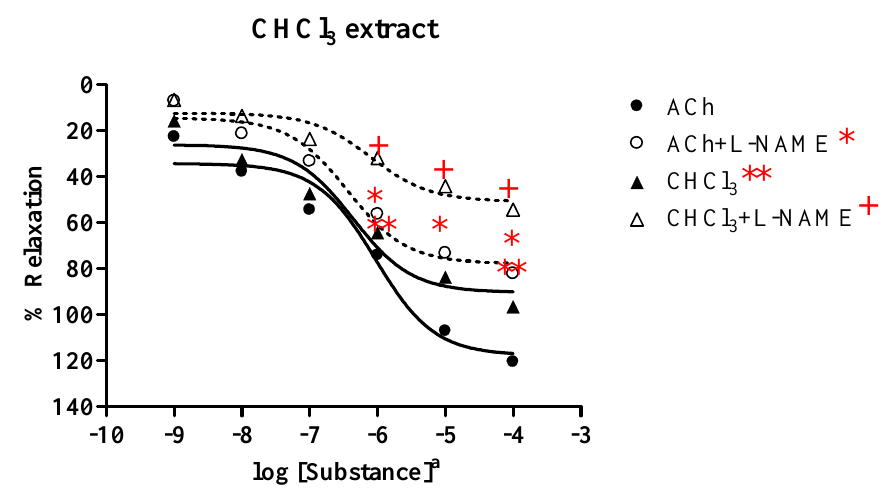
extract and ACh on the vascular function of rat thoracic aorta in Figure 3. Effect of CHCl 3 the absence or presence of 1 mM L